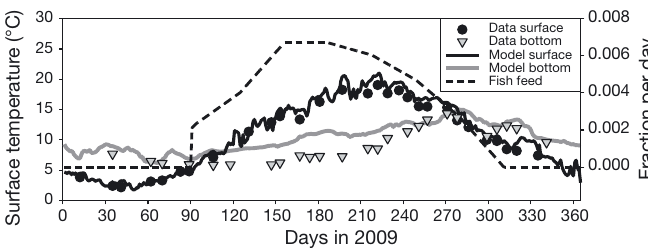
Fig. 3. Surface and bottom temperature at Romsø stn. The daily fraction of total fish feed is shown on the right